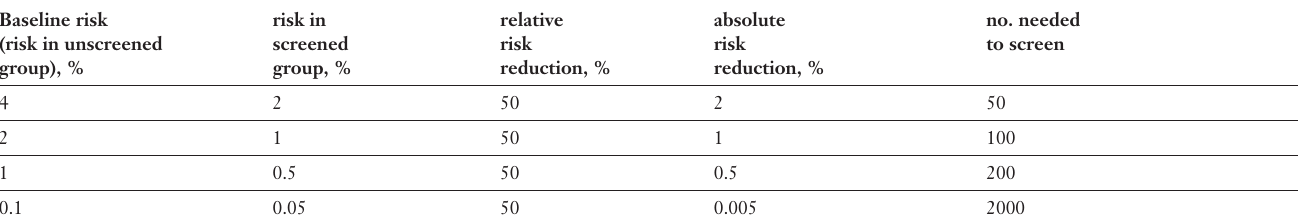
Baseline risk risk in